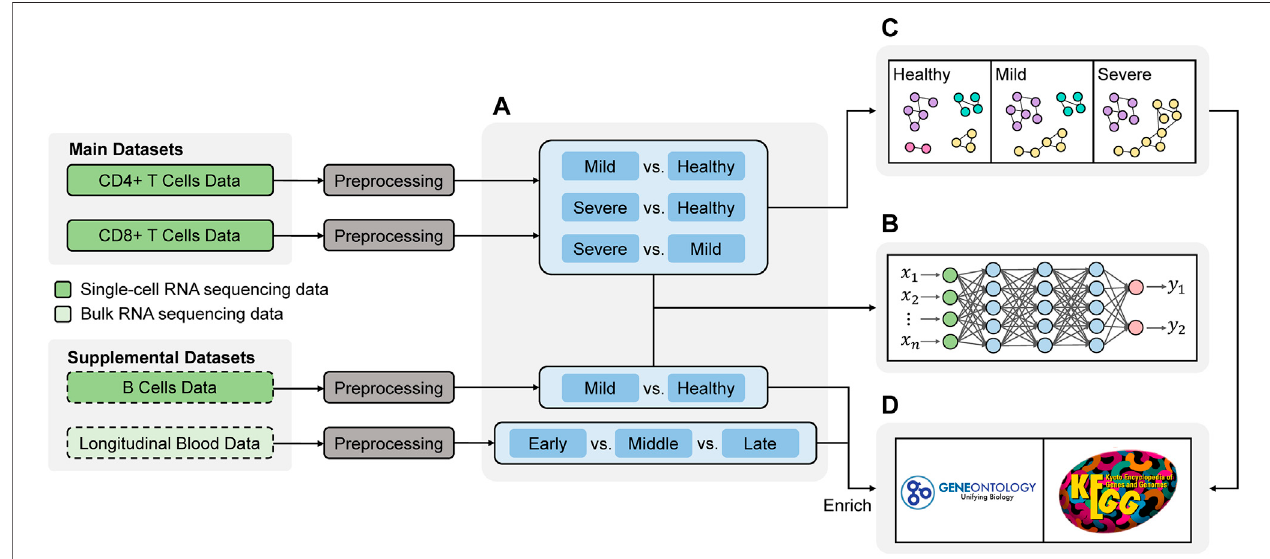
FIGURE 1 | Work fl ow of the study. The analysis primarily focused on two main datasets, and two supplemental datasets were included to enrich the fi ndings (A) DifferentialExpressionanalysistoobtainthedifferentiallyexpressed(DE)genesamongdifferentdiseasestates (B) DeeplearningforvalidatingtheDEgenes (C) Network analysis comparing the connectivity of genes in different disease states (D) Functional